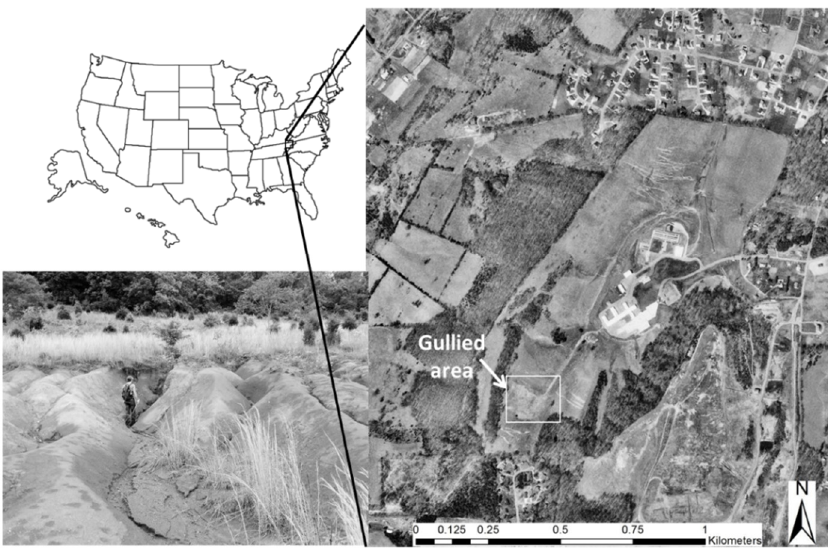
Figure 1. The study area was located in northeast Tennessee, USA on an actively eroding hillslope.